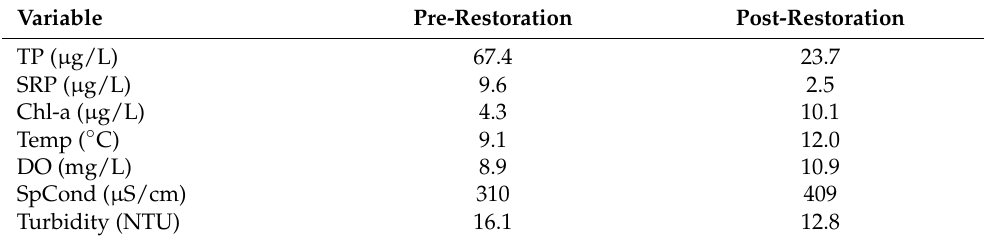
Table 4. Pre- vs. post-restoration surface water quality values for Bear Lake. Data are from spring sam- pling events (March 2016 vs. April 2020). TP = total phosphorus; SRP = soluble reactive phosphorus; Chl-a = lab-extracted chlorophyll a; DO = dissolved oxygen; SpCond = specific conductivity.